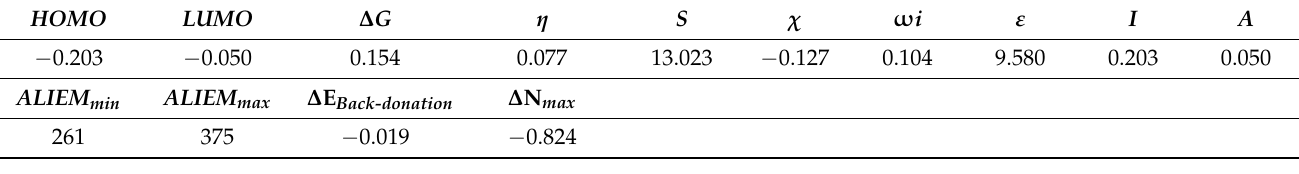
Table 4. Calculated chemical reactivity for compound 4 at the DFT/B3LYP/6-311**G (d,p) basics